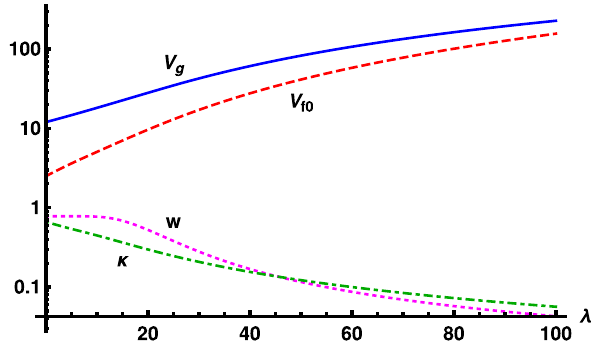
Fig. 9 Final potentials after the fit (potentials